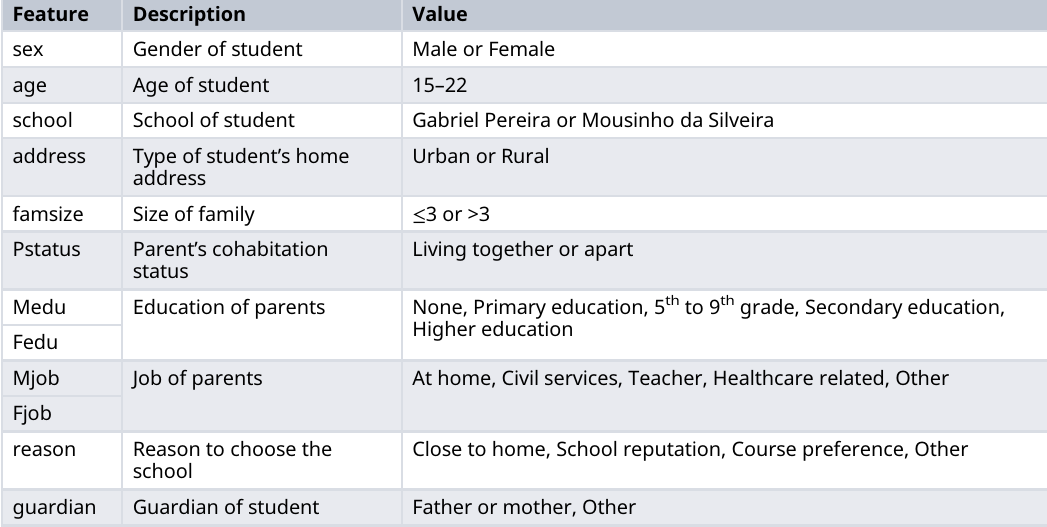
Table 1. Student background.